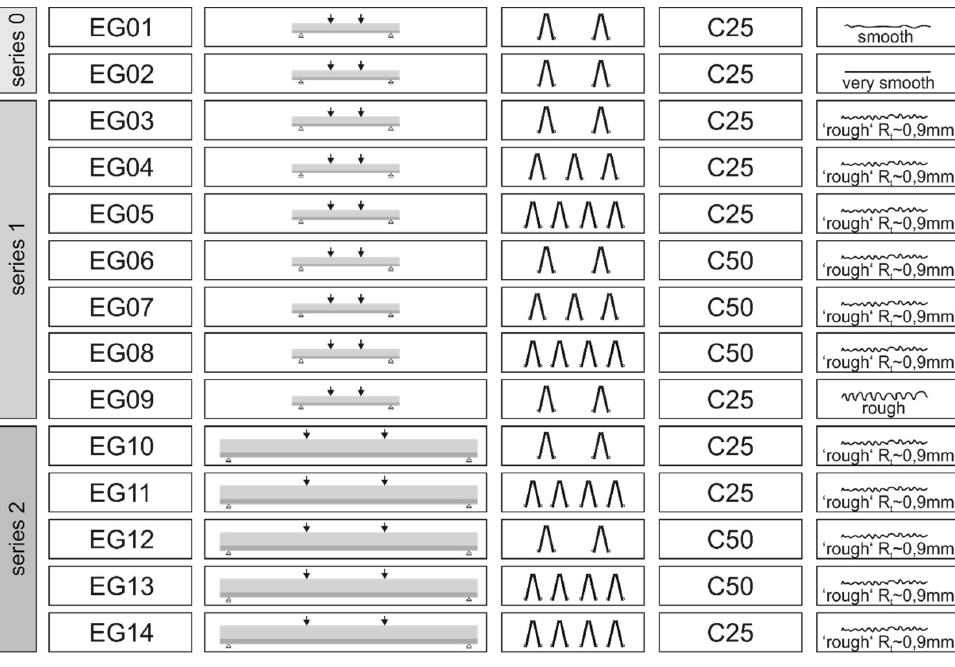
Figure 12. Overview of test specimens and test parameters [43].